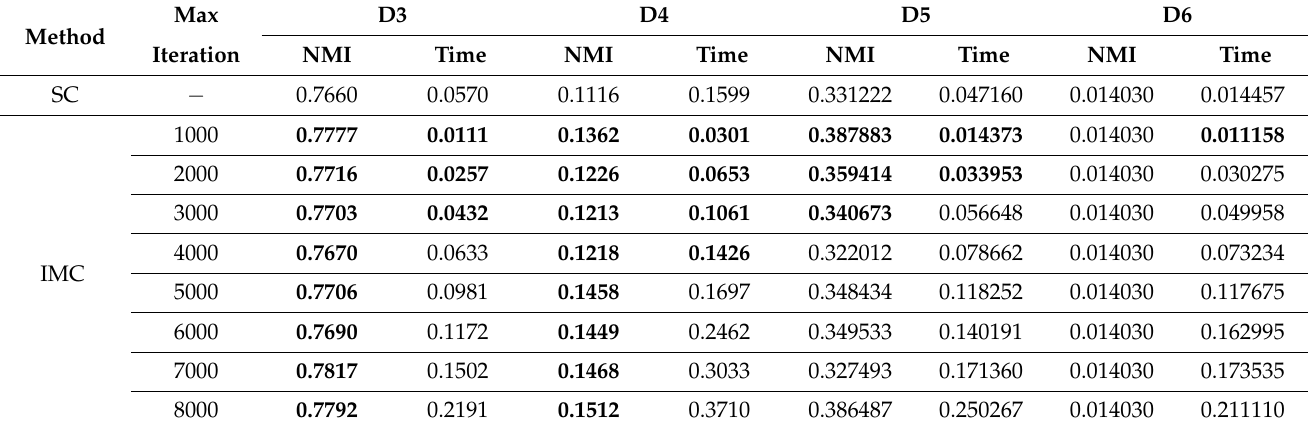
Table 3. NMI and running time comparisons of IMC with spectral clustering (SC) on UCI real datasets.